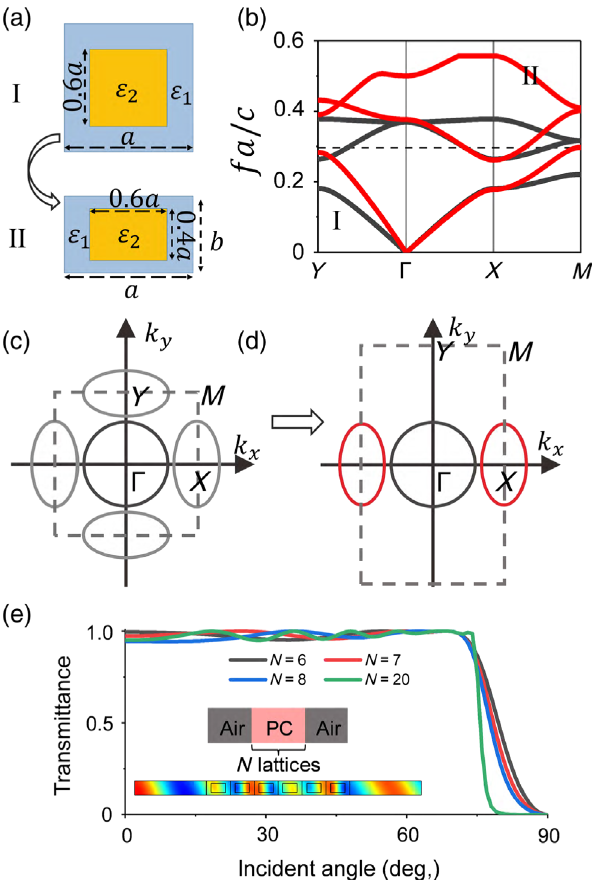
FIG. 2. The role of symmetry breaking in the PC design for shifted spatial dispersions. The unit cells (a), band structure for transverse-magnetic polarization (b), and equal frequency con- tours (c),(d) of two PCs I and II, which exhibit C v 4 and C v 2 symmetries, respectively. (e) The transmittance of the PC II with 6, 7, 8, and 20 layers. The insets show the simulation to calculate the transmittance.